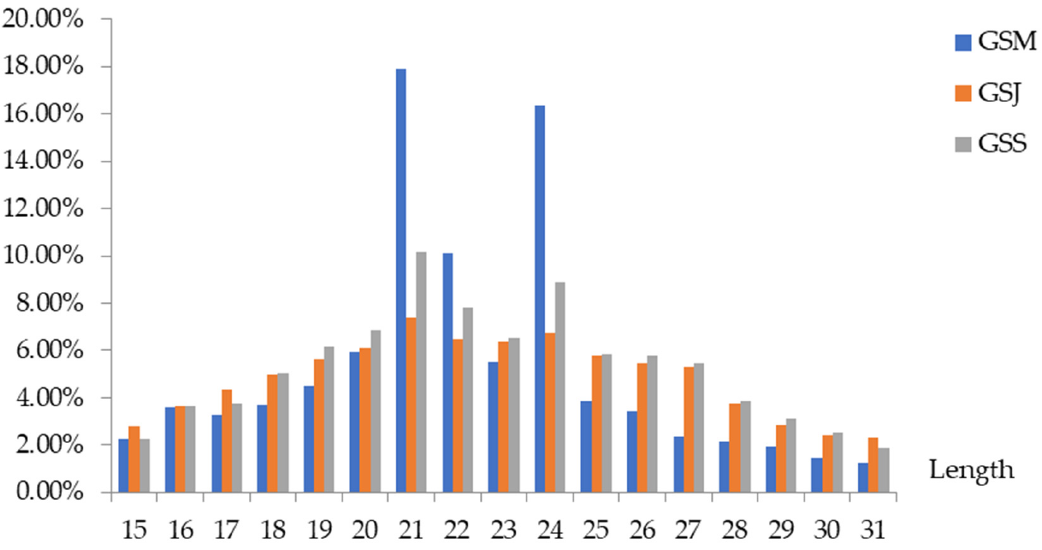
Figure 3. Differential expression levels of sRNA with different lengths in Gleditsia sinensis pods. Note: May (GSM), July (GSJ), and September (GSS); X -axis represents the length of miRNA, and the Y -axis represents the proportion of sRNAs of different lengths to total RNA. The statistics of the length distribution were based on unique valid